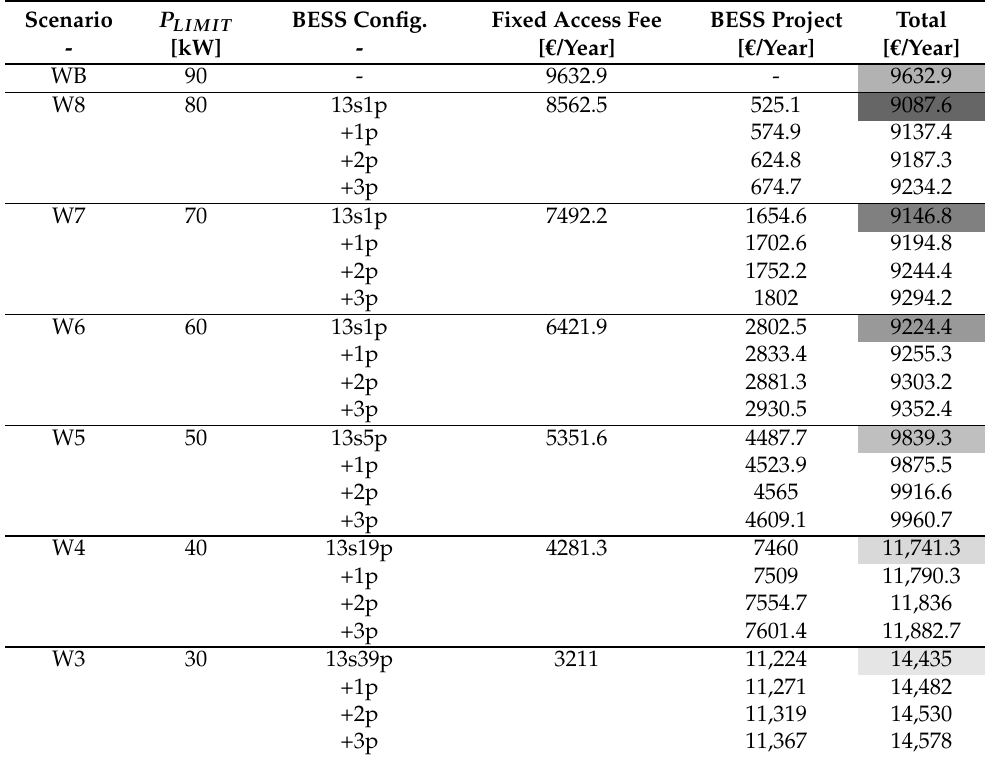
Table 8. Costs for the winter